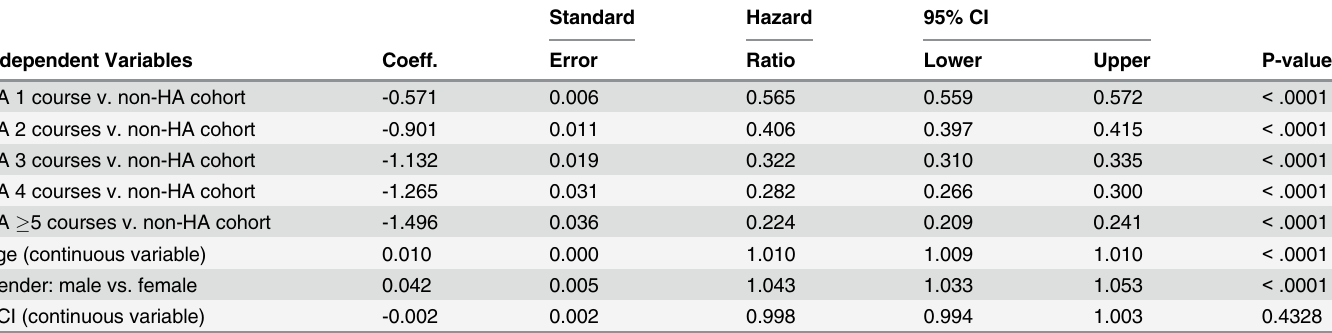
Table 2. Risk of TKR as a function of number of courses of HA injection, age, gender, and comorbidity. Coeff. is the coefficient of a Cox proportional hazards model; a negative value indicates that the variable is protective from the risk of TKR. Comorbidity is expressed as the Charlson Comorbidity Index (CCI). The P value shown is for a χ 2 evaluation of each independent variable.